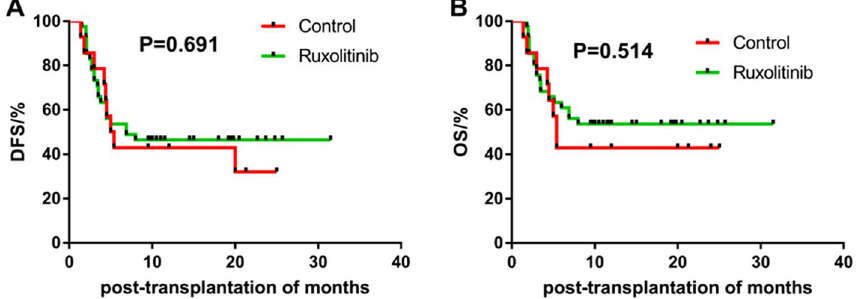
Figure 3. DFS ( A ) and OS ( B ) rates of 55 patients between the control and ruxolitinib groups. (Graphpad prism 8.0.1 https:// www. graph pad. com/ scien tific- softw are/